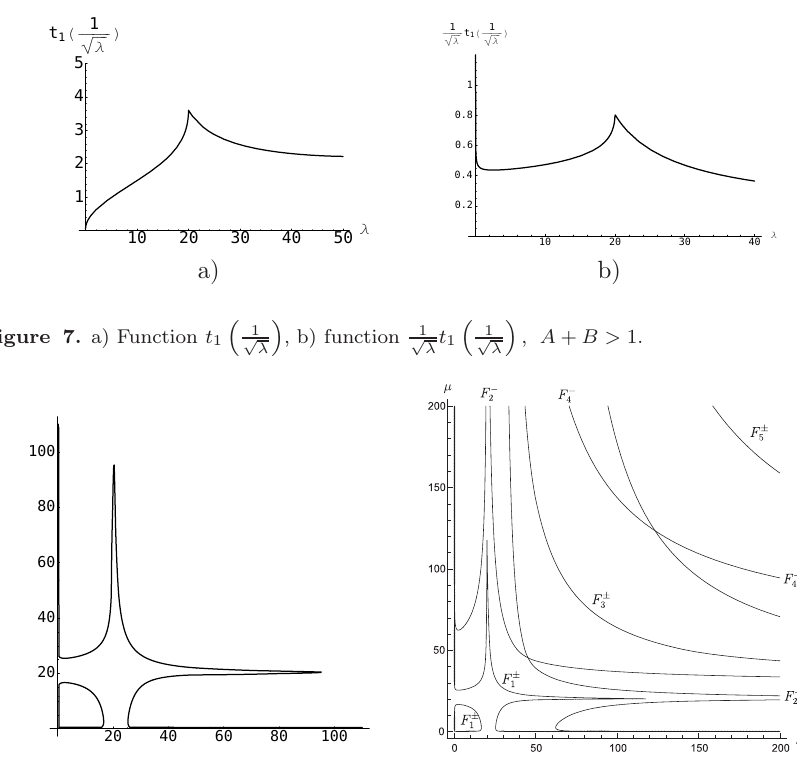
Figure 8. a) The subset F ± 1 consists of two components, the first one being bounded. b) The first five branches of the spectrum. non-monotone (Fig. 7) and as a result the first branch F ± 1 of the spectrum may consist of two disjoint sets. In Fig. 8 the first branches of the spectrum are depicted. The odd numbered branches coincide F + 1 = F − 1 , F + 3 = F − 3 , F + F − F ± 5 = 5 , the branch 1 consists of two components. The “positive” and “negative” even numbered branches F + and F − , F + and F − differ like in the 2 2 4 4 case of the classical Fučik equation. The branch F + 2 (as well as F − 2 ) consists of two infinite